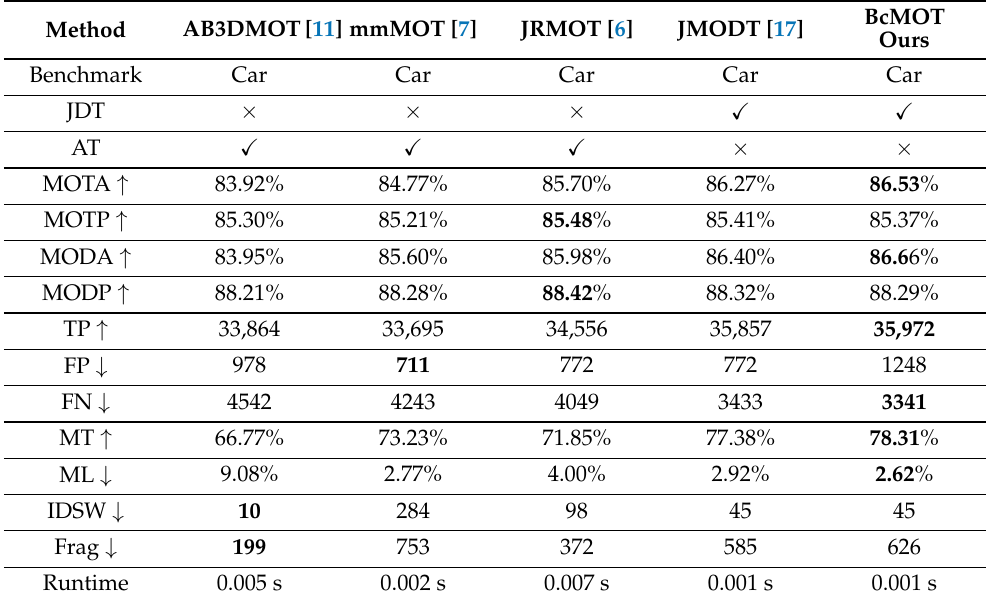
Table 4. KITTI car tracking results based on MOTA. " × " means not, while " (cid:88) " means